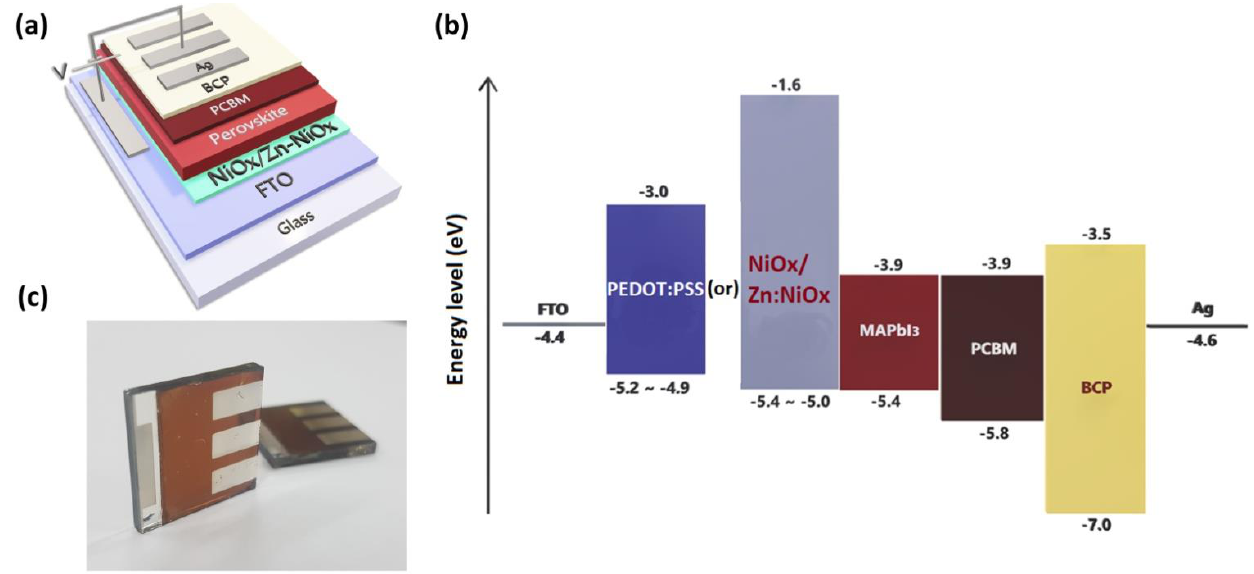
Table 1. Summary of device performance of the PSCs made with NiO x , Zn-NiO x , and PEDOT:PSS (control) HTLs.